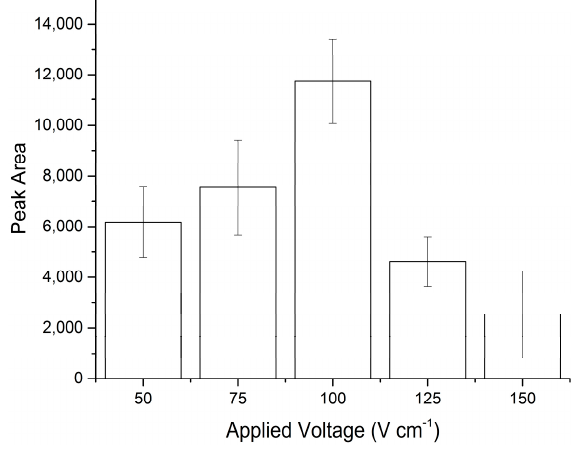
Figure 3. PCR product intensity compared to the voltage applied during the purification procedure on the microfluidic device ( n = 3). Peak area refers to the band intensity/peak area of the PCR products on the gel. Conventional off-chip positive and negative controls produced peak areas of 4768 (±780) and 93 (±93), respectively. Error bars represent the standard deviation from triplicate analysis.